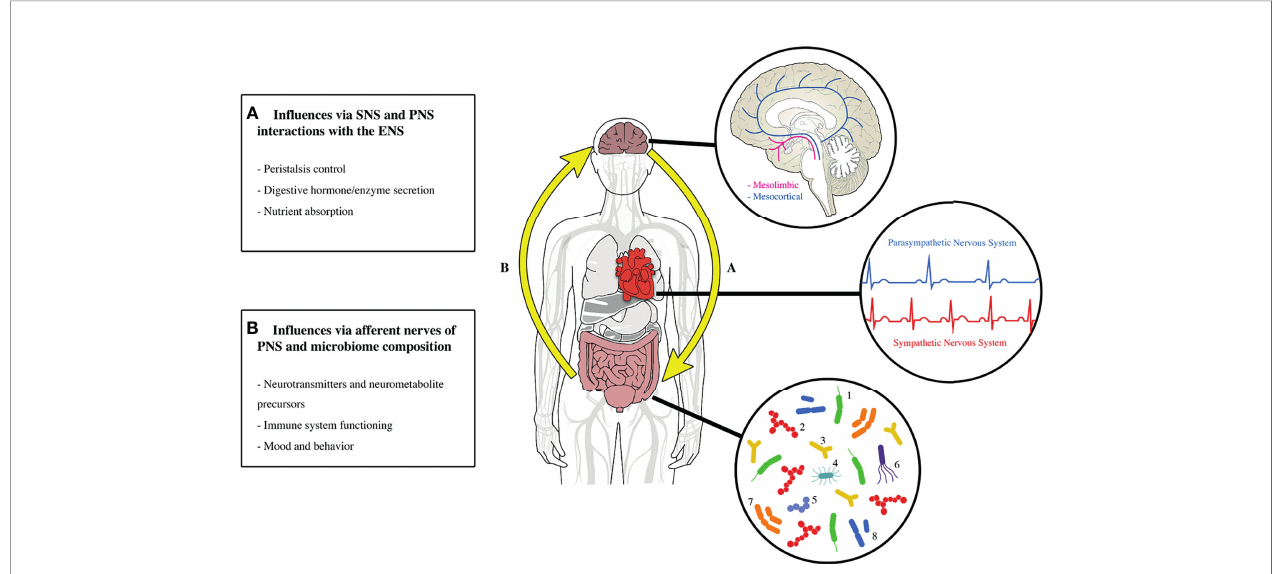
FIGURE 1 | A depiction of how the whole human affects overall functioning and behavior with an emphasis on the gut-brain axis and heart. The gut, heart, and brain operate as interdependent units. (A) Highlights the top-down communication; the brain alters heart and gut functioning via the autonomic nervous system and neuroendocrine hormones. (B) Demonstrates the bottom-up communication; gut microbiota directly and indirectly in fl uence neural functioning by producing neurotransmitters and precursor metabolites as well as modulating metabolic and immune pathways. Gut-brain communication is estimated to be ~20% top-down (efferent) and ~80% bottom-up (afferent), leading some to identify the gut and enteric nervous system as a sensory system that alters cognition, perception, mood, and behavior. The brain pop-out illustrates 2 of the major dopamine neuropathways: mesolimbic responsible for motivation and reward and mesocortical responsible for attention. The heart pop-out demonstrates the general in fl uence of the SNS and PNS on heart rate. The gut pop-out provides the common and rare microbiota that typically colonize the human gut. Microbiota Key: 1 = Bacteroides, 2= Faecalibacterium, 3 = Bi fi dobacterium, 4 = Enterobacteriaceae, 5 = Streptococcus, 6 = Escherichia coli, 7 = Eubacterium, 8= Clostridium. SNS, sympathetic nervous system; PNS, parasympathetic nervous system; ENS, enteric nervous system. Graphic by Shawn